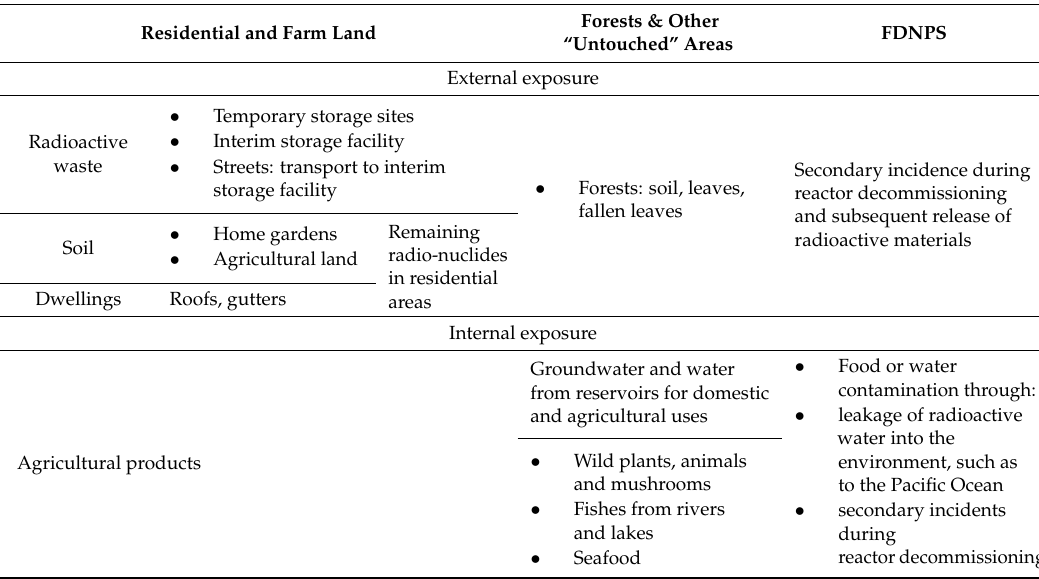
Table 1. Potential sources, causes or risks of radiation exposure that may influence public perceptions and